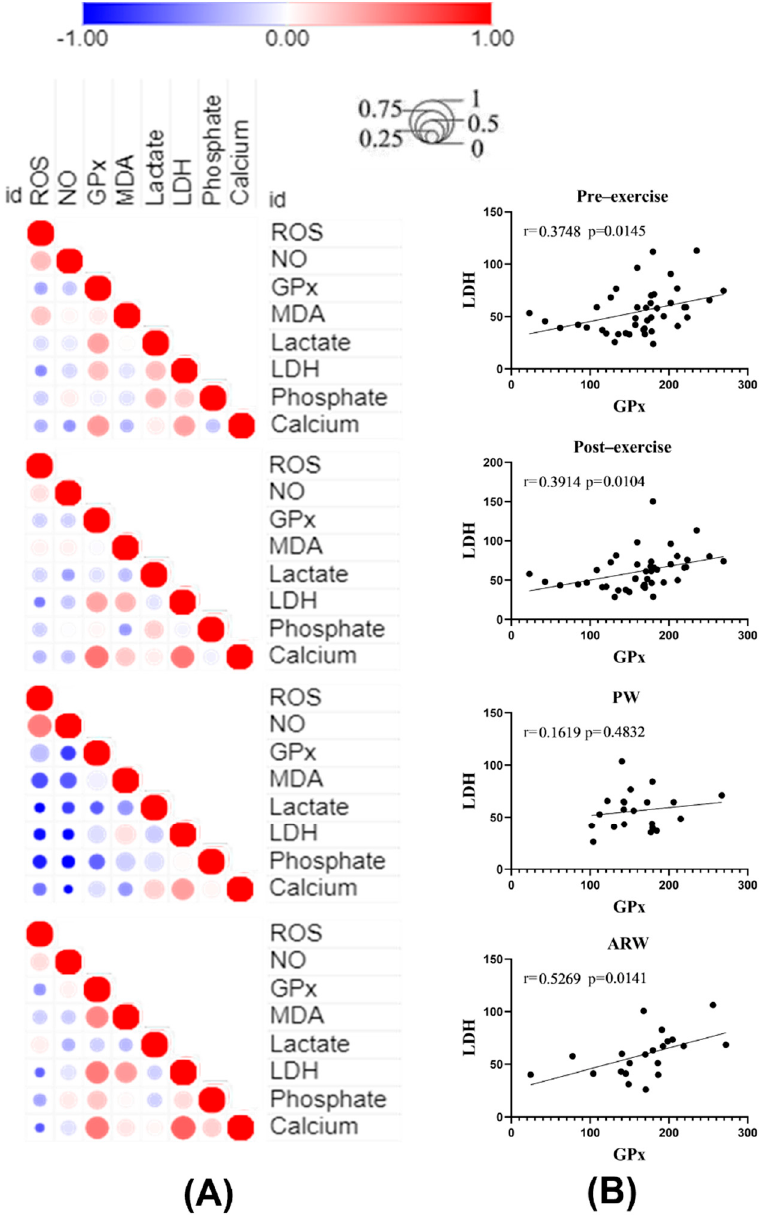
Figure 5. Pearson correlation between oxidative stress and fatigue markers. ( A ) Heatmap depicting the linear relationship between oxidative stress and fatigue markers. The color is directly proportional to the size of the circle. The deeper the hue, the larger the circle size. The circle is rated based on the absolute value of the correlation coefficient (R). The greater the size of the circle, the greater the correlation. ( B ) Pearson correlation of GPx with other oxidative stress and fatigue markers in the pre- and post-exercise groups after the consumption of PW and ARW. Abbreviations: PW, purified water; ARW, alkaline reduced water; ROS, reactive oxygen species; NO, nitric oxide; GPx, glutathione peroxidase; MDA, malondialdehyde; LDH, lactate dehydrogenase.